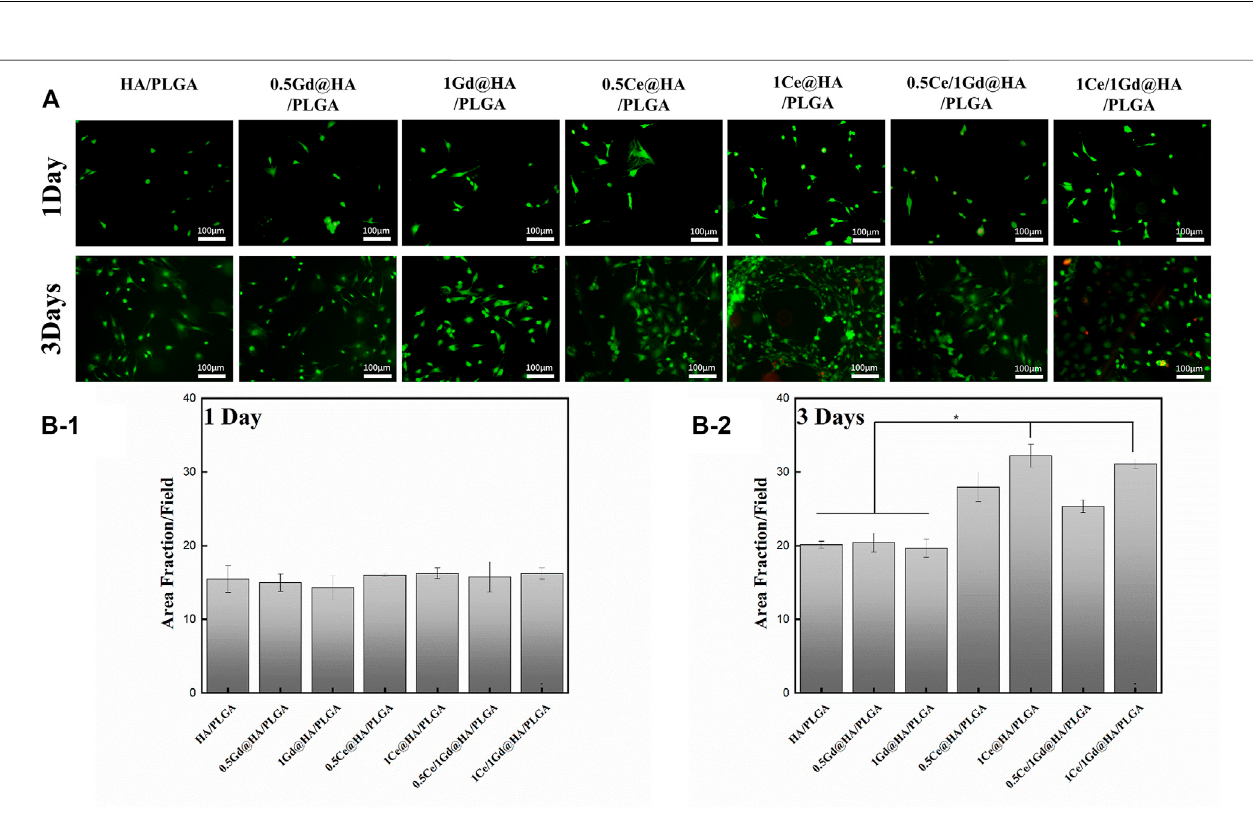
Figure 4C . As predicted, the composites doped with Gd 3+ could be clearly observed in MRI images according to T1-weighted images and parametric mapping (Sigg et al., 2016). The signal intensity of the T1-weighted images for Gd 3+ -doped composites is much higher than the others (HA/PLGA, 0.5Ce@HA/PLGA, and 1Ce@HA/PLGA). The signal intensity is highest for the 1Gd@HA/PLGA group due to the high doping concentration